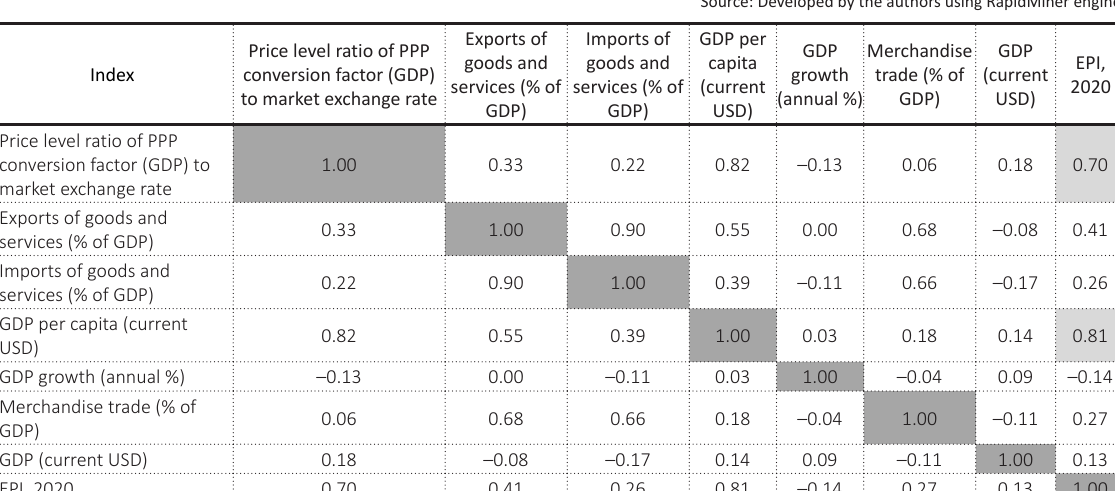
Table 2. Correlation matrix